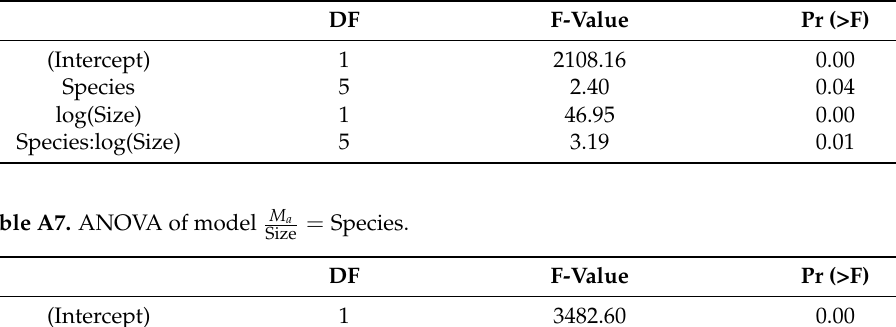
Table A4. ANOVA of a linear mixed-effects model M a